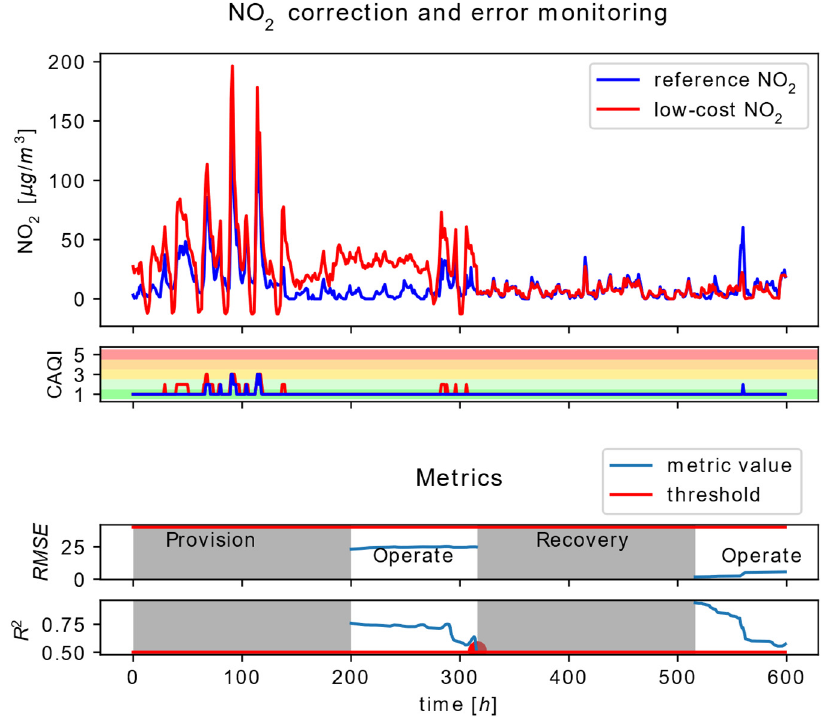
Figure 9. Time series data at the input and the output of the NO 2 correction service at Node #1.1 ( top ), the output of the CAQI service at Node #1.1 ( middle ) and the statistical parameters RMSE and R 2 as an output of the correlation service at the Node #2.1 ( bottom ).